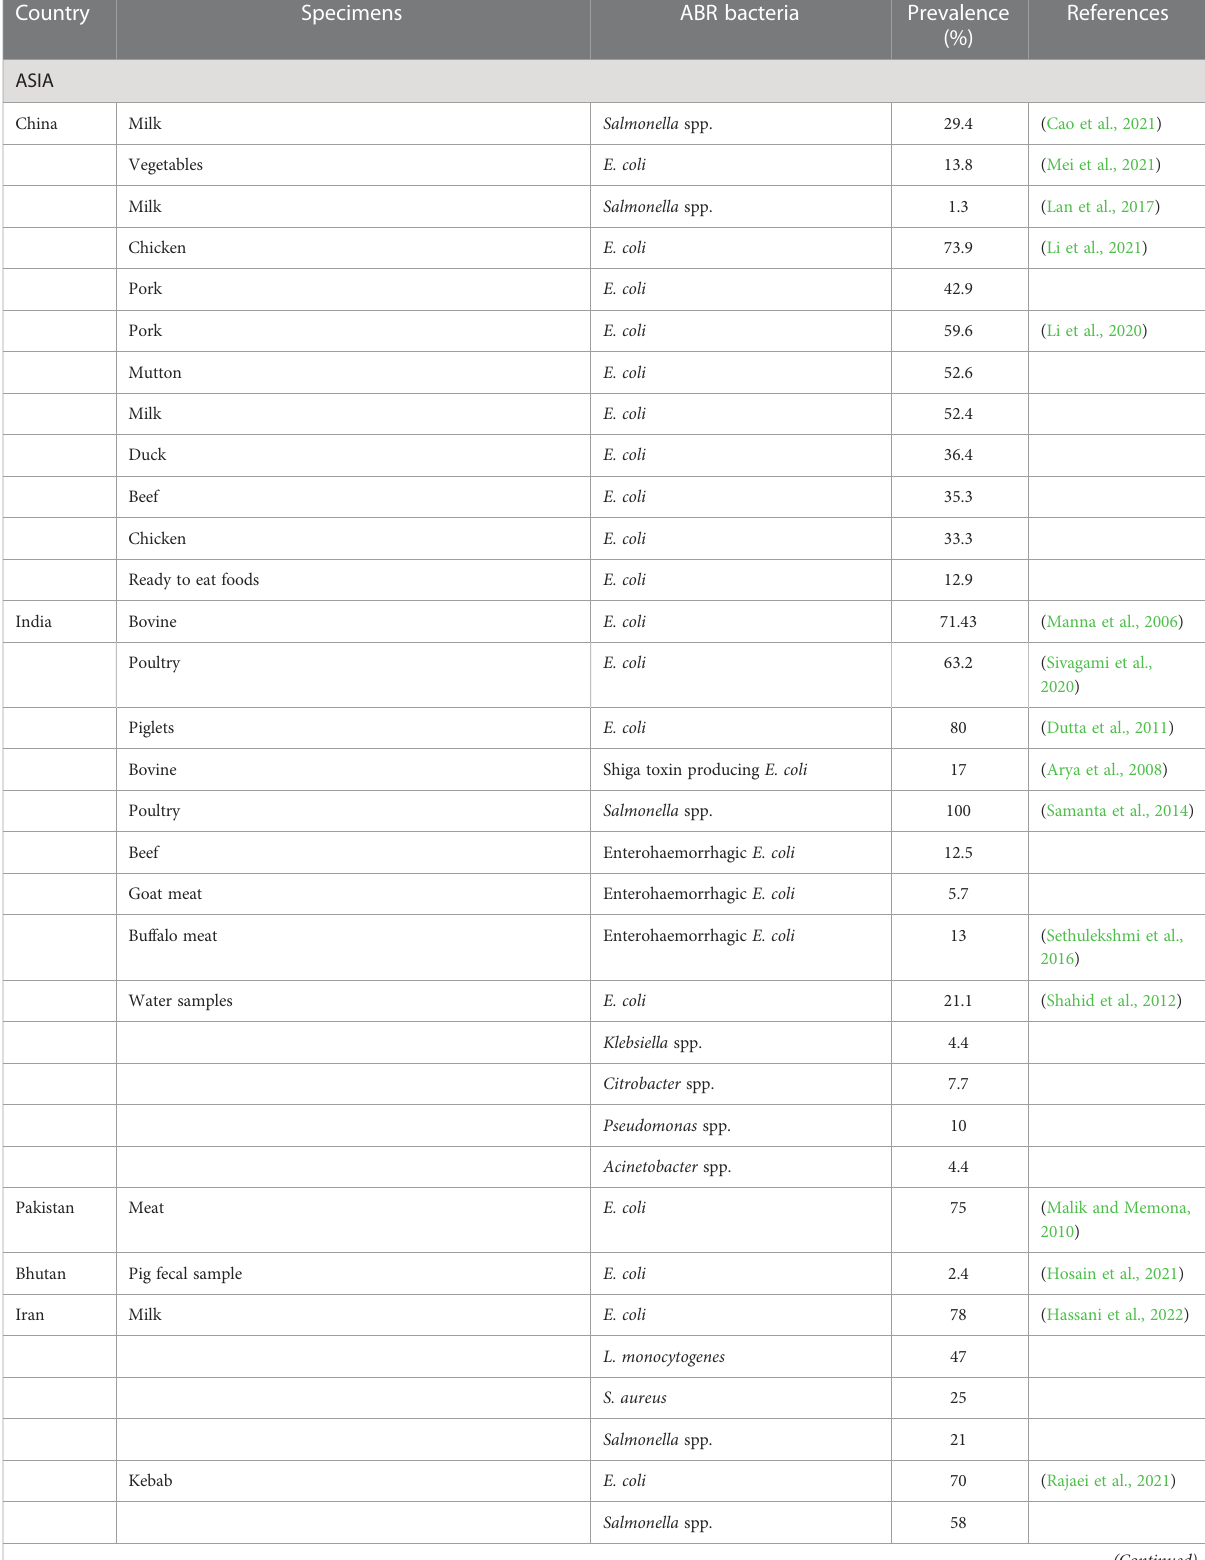
TABLE 2 Some studies reporting the prevalence of ABR bacteria isolated from food producing animals, food products and environment* [modi fi ed from Hosain et al, 2021 [108].